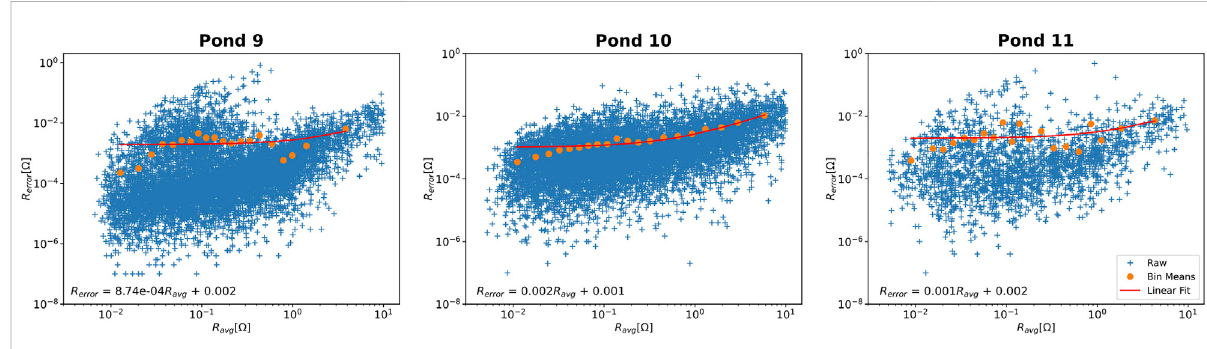
FIGURE 2 ErrordistributionoftheERTdataforeachpond,andthelinearerrormodels(valuesshowninthelowerleftcornerofeachpanel)thatwereused in the data inversion. Errors are usually small compared to the measured